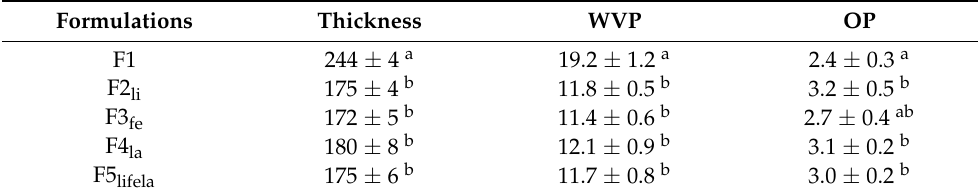
Table 2. Mean values and standard deviation of thickness ( µ m), water vapour (g · mm kPa − 1 h − 1 m − 2 ) and oxygen ( × 10 15 cm 3 m − 1 s − 1 Pa − 1 ) permeabilities of the different films after one week of storage at 53% relative humidity and 25 ◦